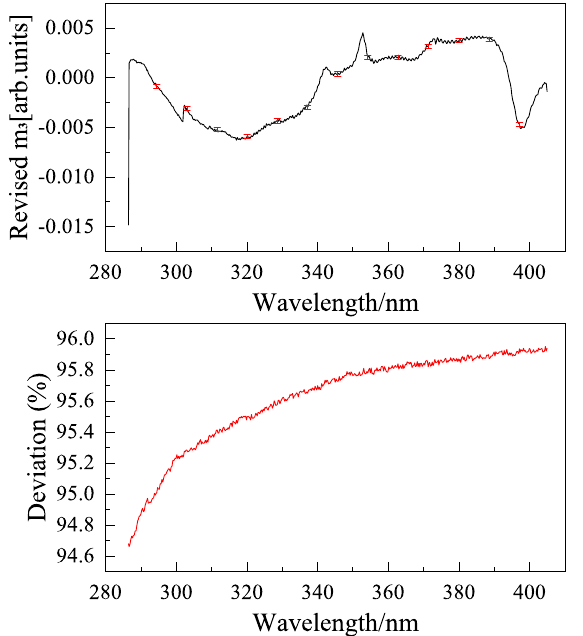
Figure 18. Comparison of Mueller matrix element m 3 for channel 1 before and after correction for UV hyperspectral instrument.